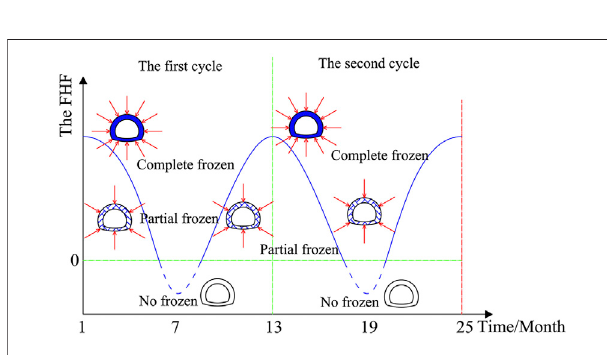
FIGURE 8 | Periodic variation characteristics of the